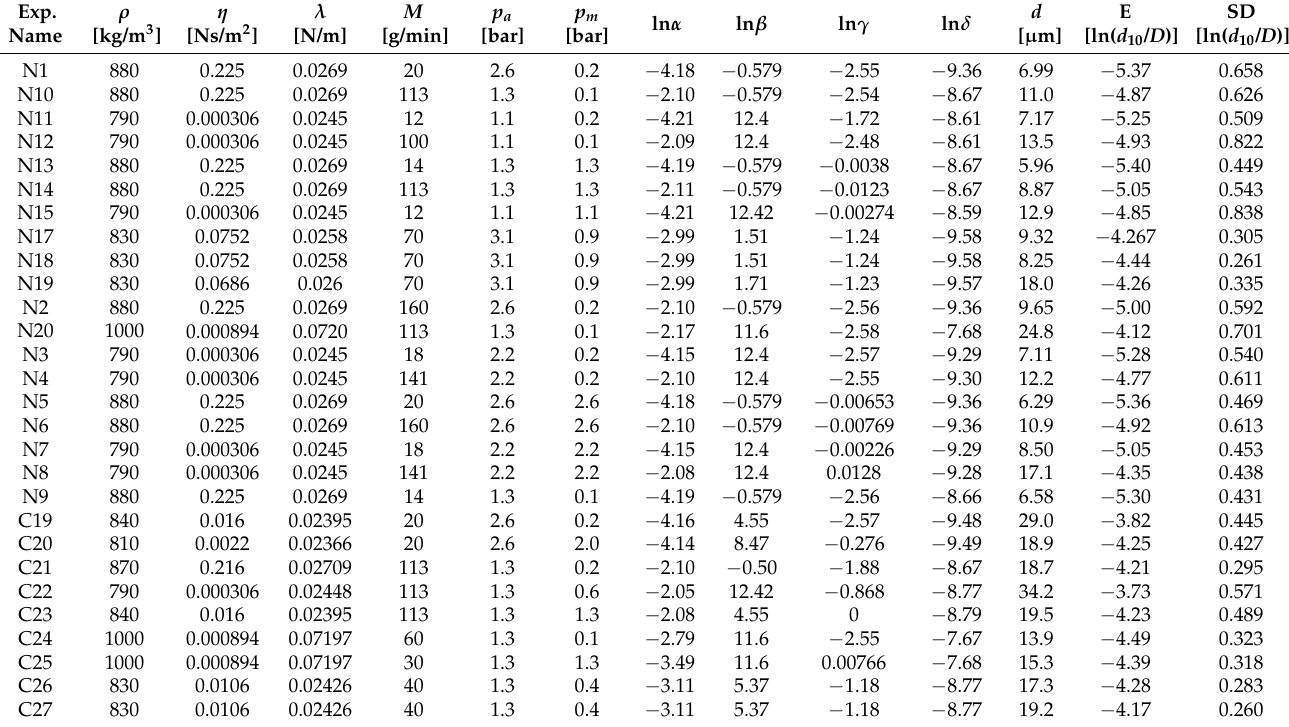
Table 3. The two droplet size parameters, E[ln( d 10 / D )] and SD(ln( d 10 / D )), were defined on a logarithmic scale due to the expected log-normal size distribution of the droplets. Table 3. Experiments conducted for construction of the semi-empirical model for prediction of droplet size and its standard deviation. ( ρ = density, η = viscosity, λ = surface tension, M = dispersion flow, p a = atomization air pressure, p m = microclimate air pressure, ln α , ln β , ln γ , and ln δ –reduced quantities, d –experimentally determined average droplet size; E[ln( d 10 / D )] = average of natural logarithms of experimentally determined droplet sizes; SD(ln( d 10 / D )) = standard deviation of natural logarithms of experimental determined droplet